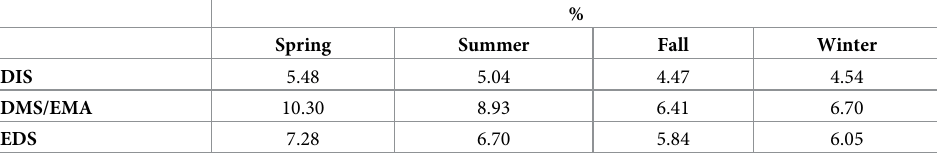
Table 5. Prevalence of DIS, DMS/EMA, and EDS for each season in the total sample.